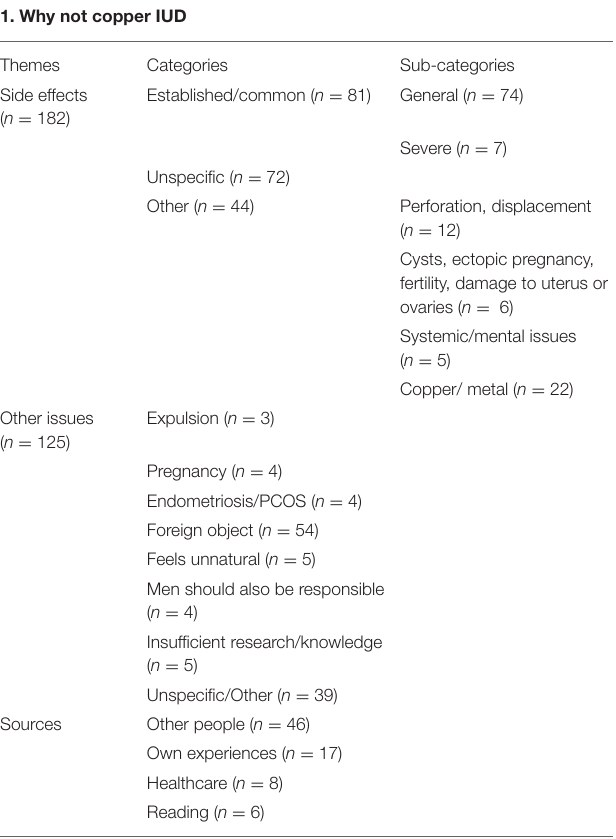
TABLE 6 | Open survey responses regarding reported unwillingness to use a copper IUD: themes and